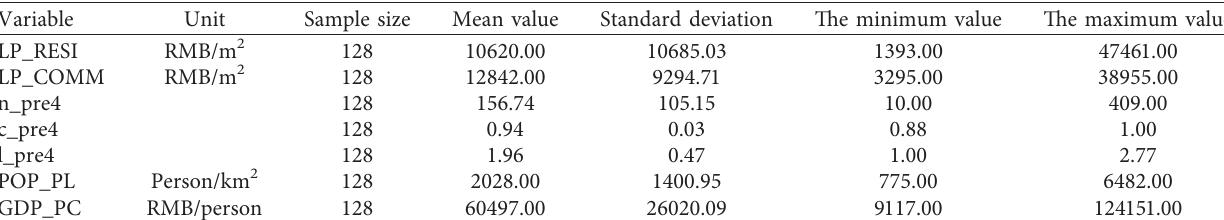
Table 3: Descriptive statistical analysis of model